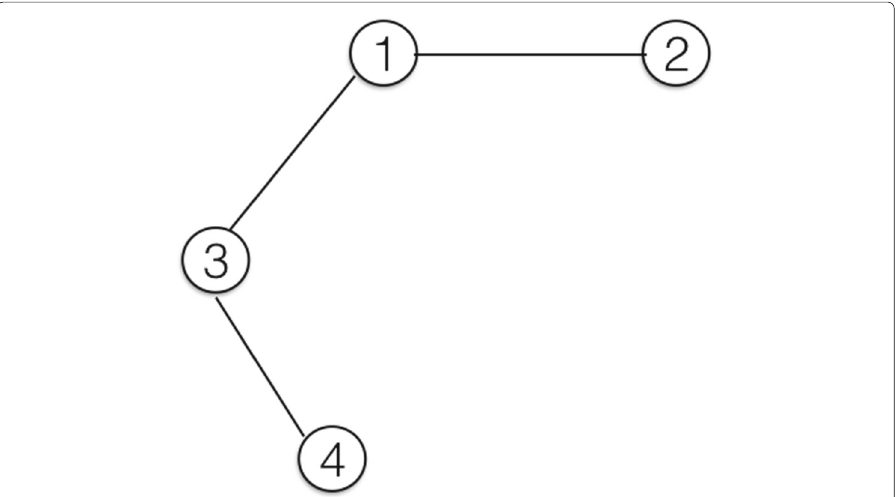
common physicians.